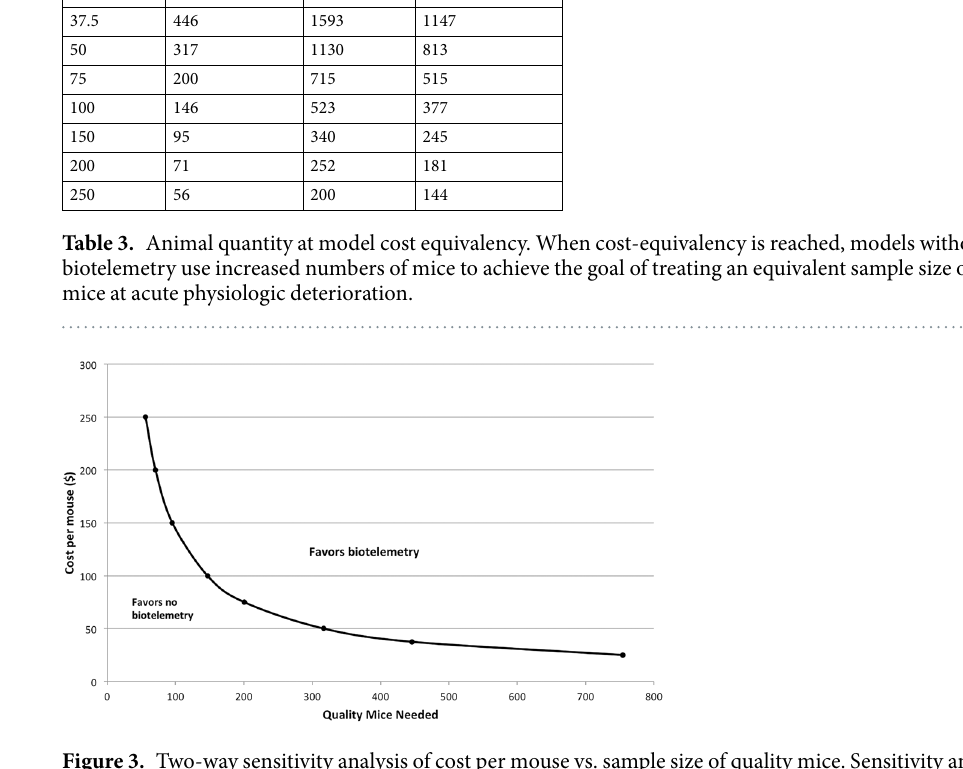
Figure 3. Two-way sensitivity analysis of cost per mouse vs. sample size of quality mice. Sensitivity analysis defines areas of intersection on the plot where model choices can be made purely based upon monetary cost. Area above the curve favors incorporating biotelemetry into cecal ligation and puncture experiments; area below the curve favors cecal ligation and puncture without